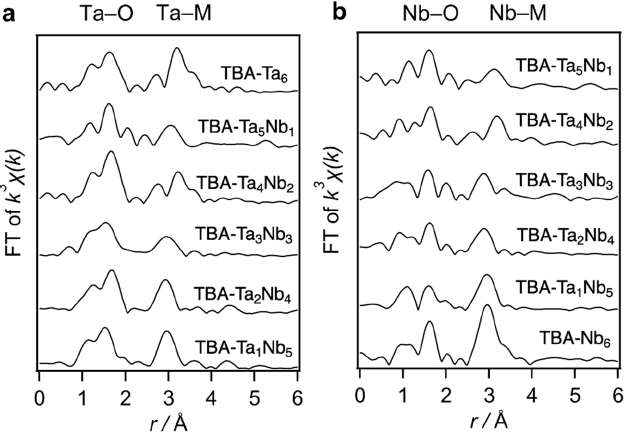
Figure 1. ( a ) Ta L 3 -edge and ( b ) Nb K-edge FT-EXAFS spectra of TBA-Ta x Nb 6 − x . The Ta–O (Nb–O and Ta–M (Nb–M) are shown in r ranges of 1.2–2.0 Å and 2.5–3.4 Å ,